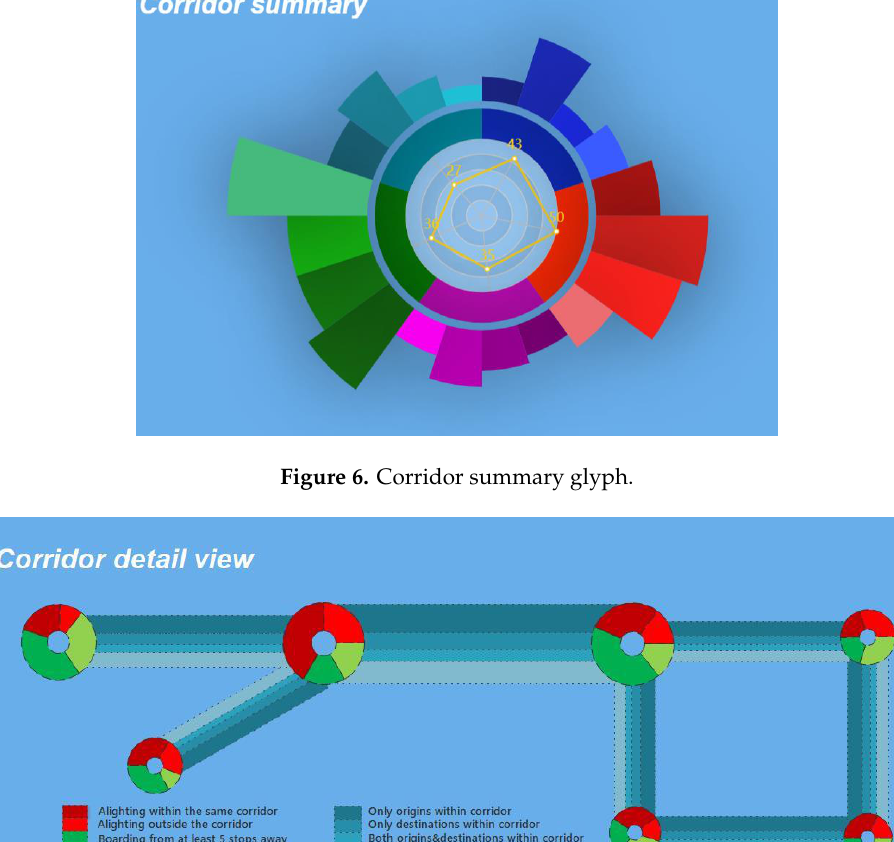
Figure 8. Transit stop glyph. 3.5.4. Correlations between Corridors and Communities In the previous sections, we introduced our approaches to discover primary transit corridors with significant travel demands and mobility communities with similar travel patterns. Furthermore, geovisual analytics can be performed to examine correlations between these two identified time-varying mobility representations. An integrated parallel coordinate plot is designed to describe their correlations. For any pre-specified time interval, we can draw identified corridors as polylines and represent discovered communities as vertical parallel axes. For each corridor (i.e., polyline), the intersection point on an axis (i.e., a community) indicates the number of transit passengers who originate from the community towards the corridor. In this way, spatio-temporal correlations between each corridor and each community can be illustrated in a compact manner. We can easily find which community contributes the biggest portion of transit flow to a particular corridor or identify which corridor is the most correlated one for a specific community. We can also get to know the composition of any corridor or community. For example, the parallel coordinate plot